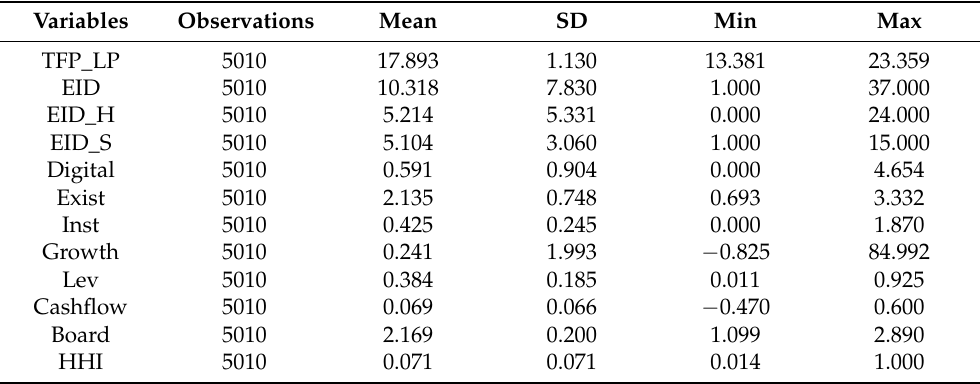
Table 1. Descriptive statistics of the main